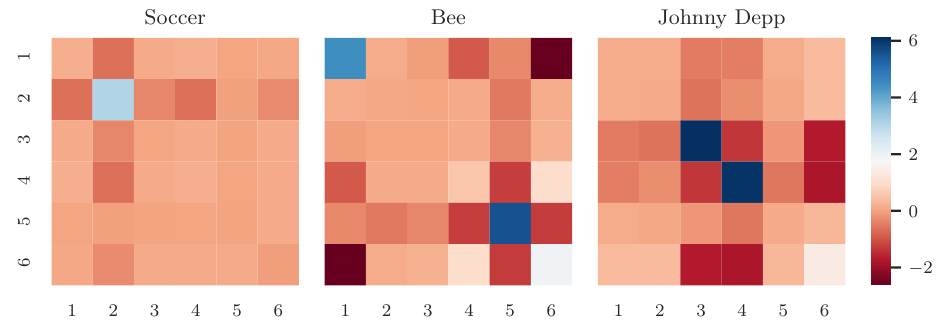
Figure 6. Colored heatmap of affinity tensor R , trained on the Wikipedia data represented as input tensor using automatic gradient methods. Table 7. Top 10 representative words per dimension of the basis matrix A (cid:48) , trained on the wikipedia data as input tensor using automatic gradient methods.